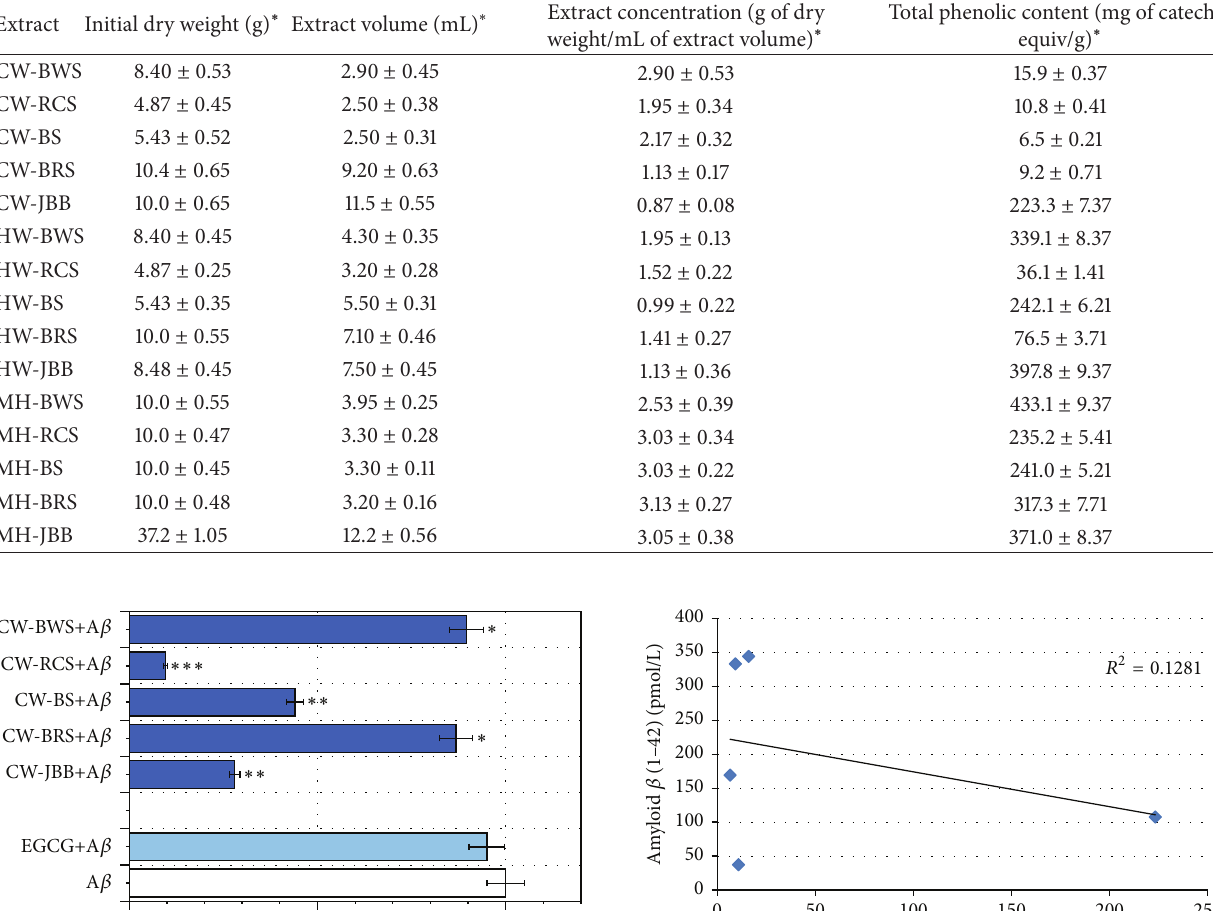
Table 1: Extract concentrations from plant sprouts. We selected five plant sprouts (buckwheat sprout (BWS), red cabbage sprout (RCS), broccoli sprout (BS), brussels sprout (BRS), and Japanese butterbur sprout flower buds (JBB)). Plant sprouts (100g) were minced into 5 mm fragments and extracts were obtained with cold water (CW, 20 ∘ C), hot water (HW, 100 ∘ C, 10 min), and methanol (MH) overnight at room temperature. Extract concentrations were expressed as gram of dry weight/mL of extract volume. The concentration of plant sprouts’ extracts (PSE) was calculated as catechin equivalents per gram of plant sprouts. ∗ Means ± standard deviation (SD) of three independent experiments. Extract Initial dry weight (g) ∗ Extract volume (mL) ∗